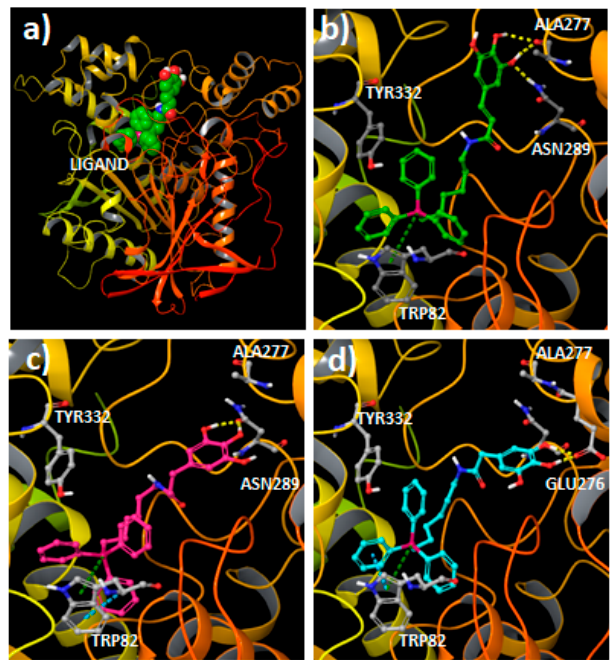
Figure 3. ( a ) General view of compound 1 (CPK representation) inside the BChE (ribbons) extracted from docking simulations; ( b ) Pose generated by docking for compound 1 (green carbons) in the BChE; ( c ) Binding mode extracted for compound 2 (pink carbons) in the BChE; ( d ) Binding mode calculated by docking for compound 3 (color code: hydrogen bonds represented in yellow dashes, green dashes for π –cation interactions, blue dashes for π – π stacking interactions).